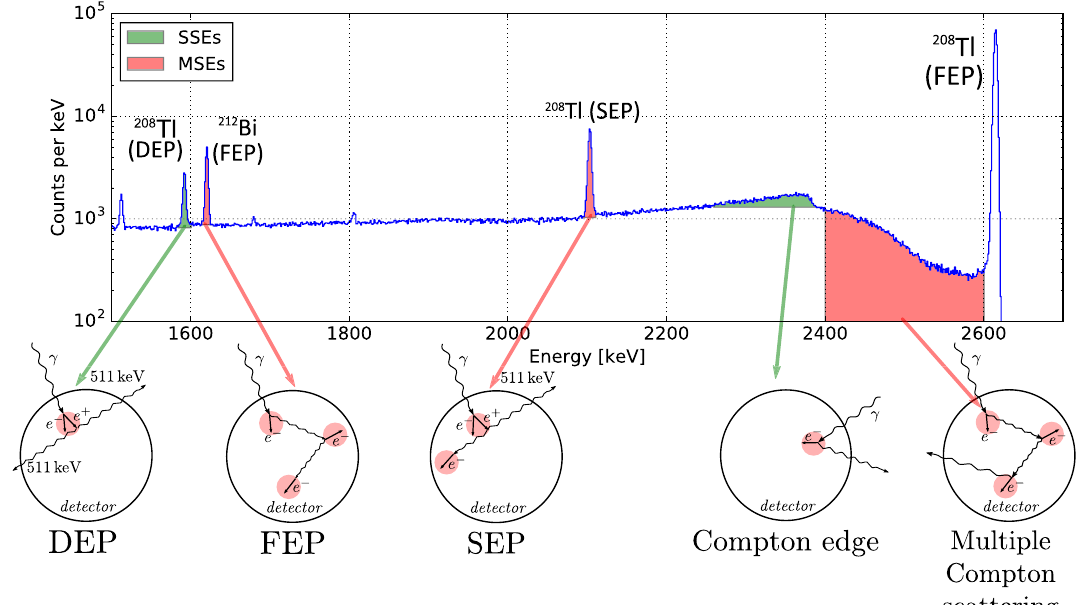
Fig. 5 228 Th energy spectrum with the marked energy regions rich in single-(green)andmulti-siteevents(red).Eventtopologycharacteristic for each energy region is sketched below. All peaks and the Compton edge region have always a small admixture of events of opposite type